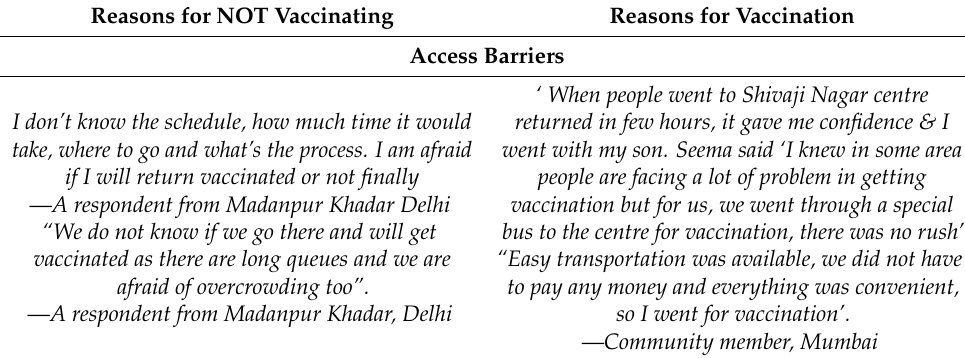
Table 17. Description of theme Access issues with verbatim.